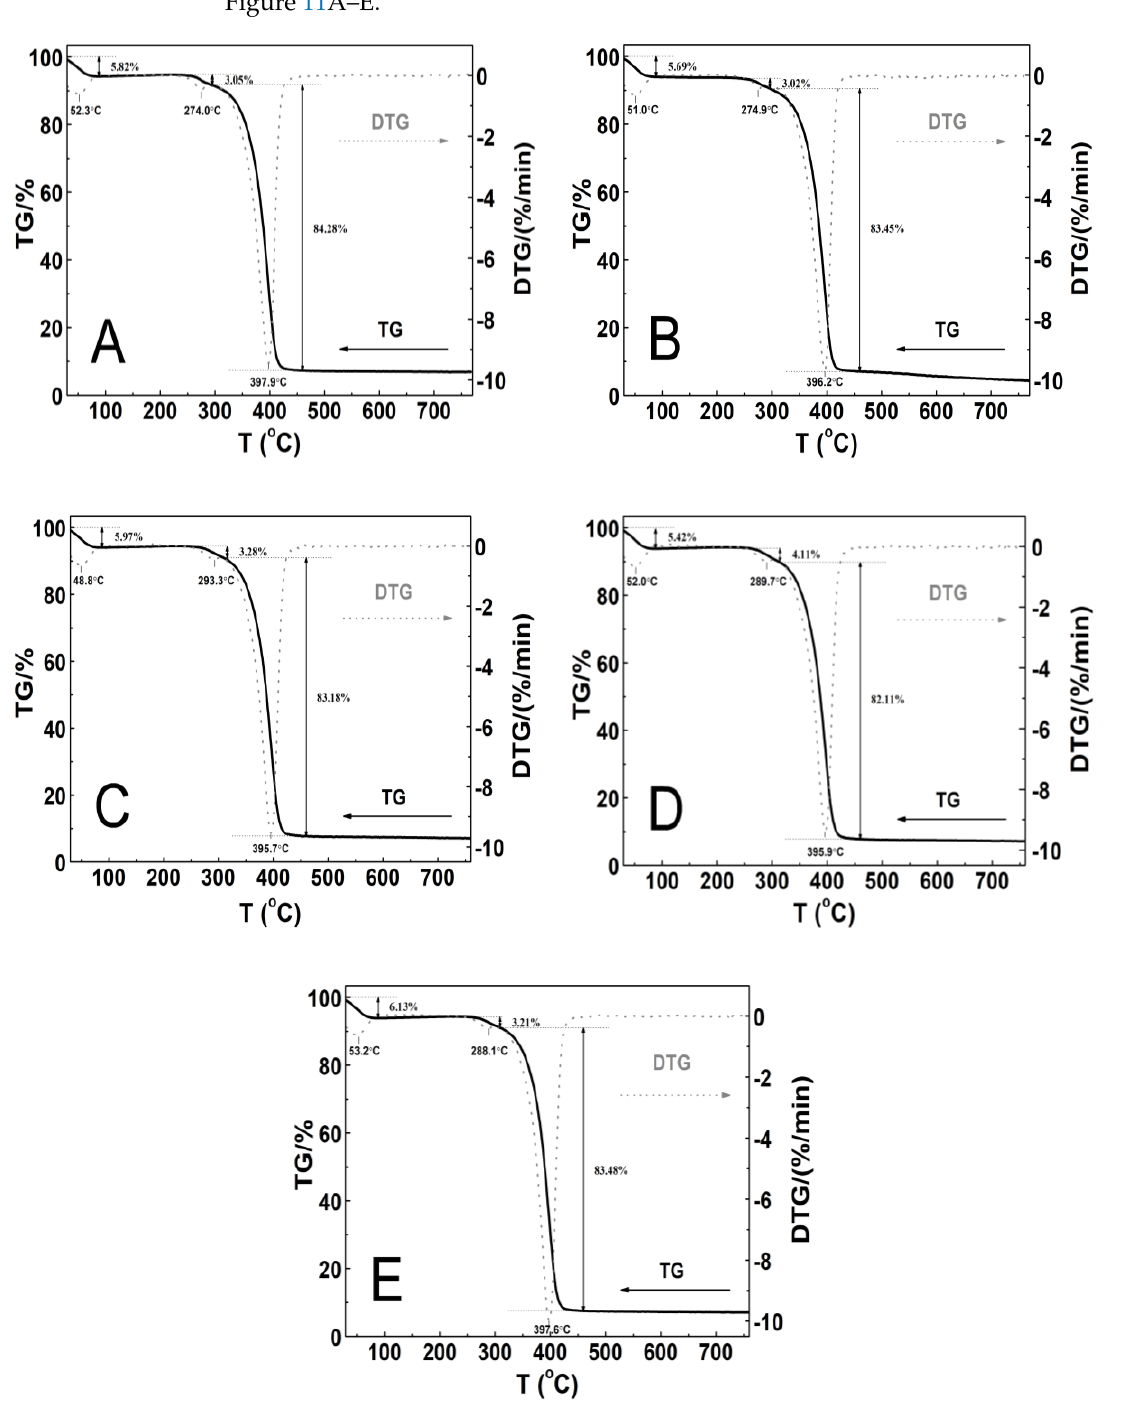
Figure 11. The thermoanalytical curves TG—solid line; DTG—dashed line; these were obtained at the heating rate β = 5 °C min −1 in a nitrogen atmosphere at 50 mL min −1 for polymers P1 ( A ), P2 ( B ), P3 ( C ), P4 ( D ), and P5 ( E ).